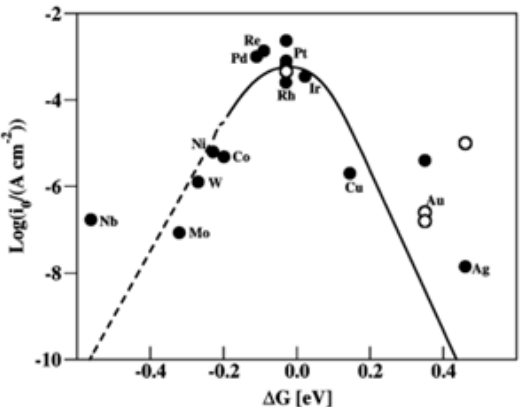
Figure 3. HER Volcano plot for metals (Reprinted with permission from Ref. [15]. Copyright 2010, American Chemical Society).